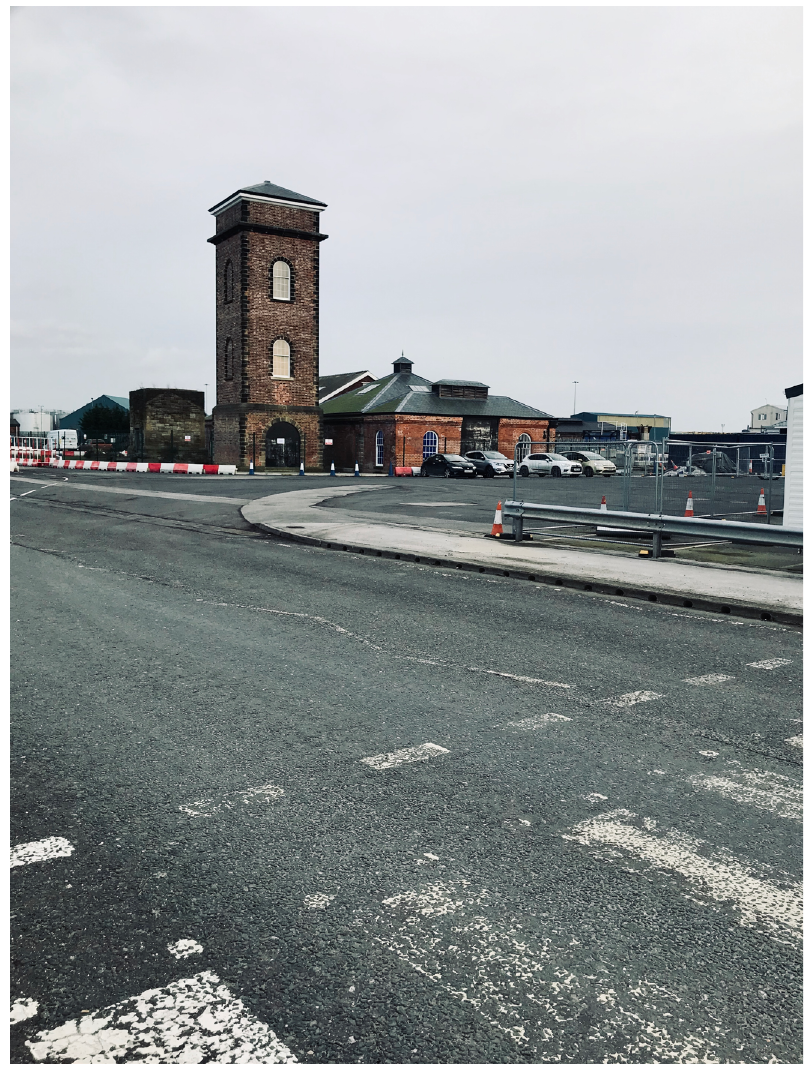
Grade II Listed Hydraulic Tower and Pump House, original photo by author,